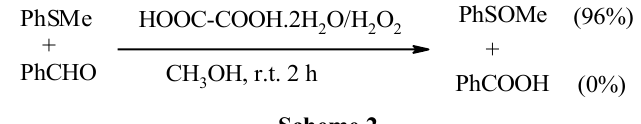
Table 4. Comparison of HOOC-COOH.2H of